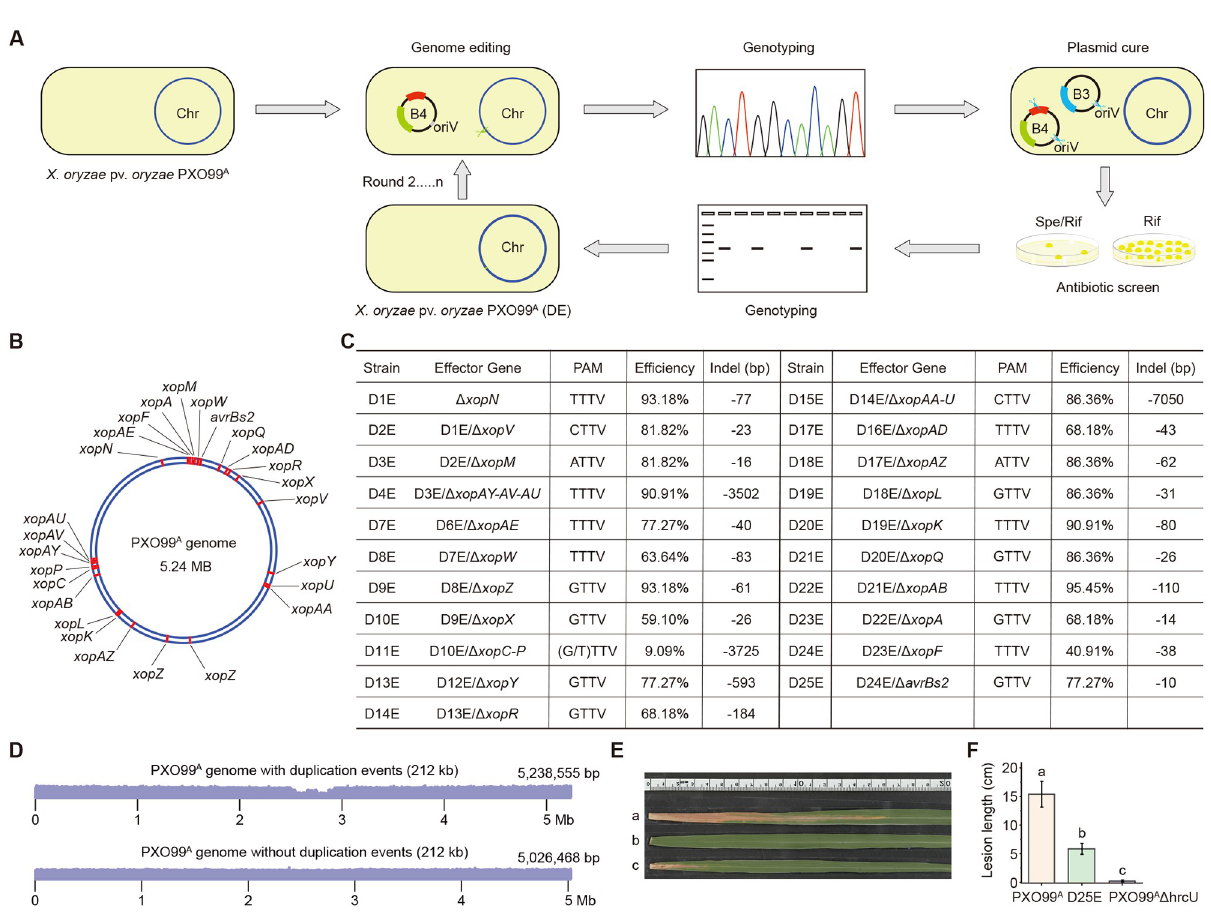
Fig 3. Iteratively knocking out all 25 non-TAL effector genes in Xoo PXO99 A . (A) A protocol for iterative rounds of genome editing in PXO99 A . The pHM1B4 plasmid was transformed into PXO99 A competent cells by electroporation. Surviving colonies were genotyped by Sanger sequencing of the targeted gene, and then the mutant strains that meet the requirements were selected for plasmid-curing. Determination of successful plasmid elimination was done by screening in media and PCR assay, and a plasmid-free mutant was used for the next round of knockout operations. Spe, spectinomycin; rif, Rifampicin. (B) The positions of all 25 non-TAL effectors in the PXO99 A genome (NC_010717.2) are marked in red. (C) The table shows the name, target gene(s), PAM sequence, efficiency, and deletion size of the xop mutants obtained in each round of genome editing. (D) Genome-wide coverage of PXO99 A when aligned back to the genome with the 212 kb duplication event (top) and the genome without the 212 kb duplication event (bottom). (E) Disease phenotypes of Kitaake after inoculation with Xoo strains. a, PXO99 A ; b, PXO99 A Δ hrcU; c, PXO99 A D25E. (F) Disease lesion lengths on Kitaake. Lesions were measured 14 days post inoculation. All values represent means ± s.d. (n = 8, 5 replicates). Values with different letters significantly differ from each other (Tukey’s test, P < 0.05).